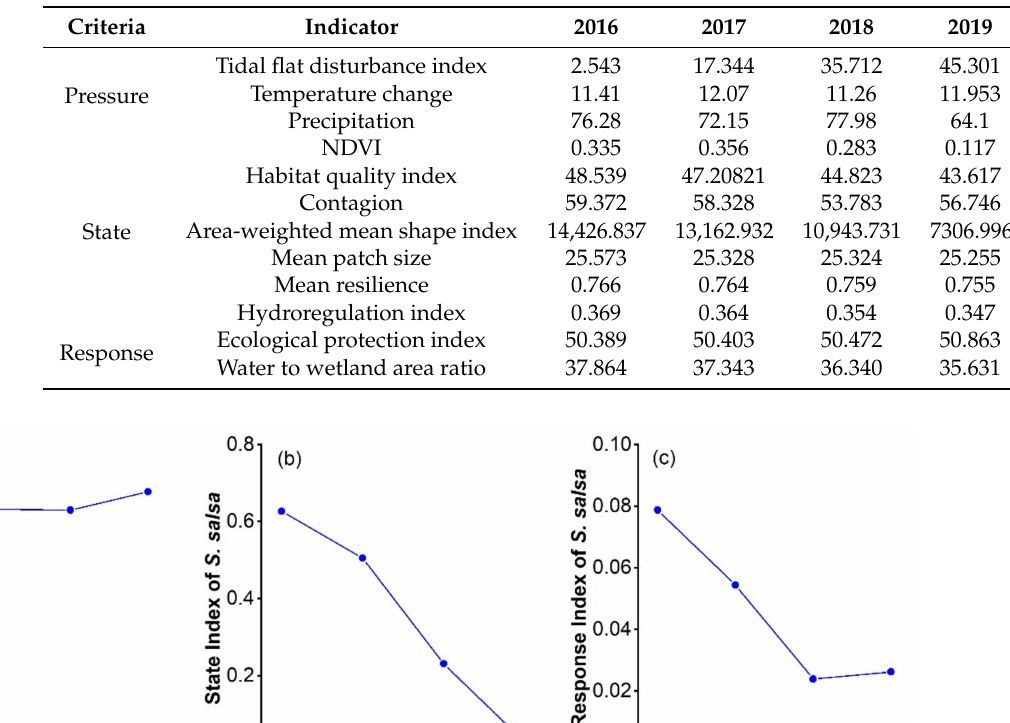
Table 6. Information on each indicator of the PSR model from 2016 to 2019.